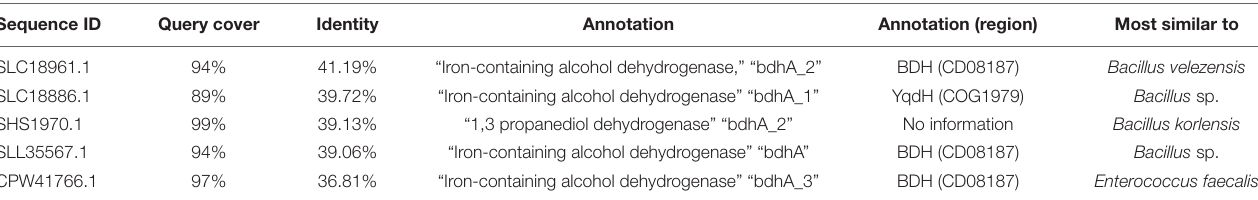
FIGURE 5 | The proposed mechanism for survival of E. coli in glutaraldehyde. (A) % Glutaraldehyde conversion (degradation) by the evolved strains, knockouts, and their respective parental strains. The standard error is shown for duplicates. The p -values are shown above the brackets for each comparison (one-tailed t -test for independent means). (B) Growth of evolved strains, knockouts, and their respective parental strains in 250 µ M of non-toxic 1,5-pentanediol. Such concentration was four to six times higher than the maximum concentration of glutaraldehyde in which evolved strains were able to grow at the otherwise same growth conditions. The standard error is shown for duplicates. (C) Michaelis-Menten kinetics of YqhD at different glutaraldehyde concentrations. K M of YqhD for glutaraldehyde was calculated to be 0.55 ± 0.09 mM (SEM; n = 3 biological replicates). 0.6 mM NADPH and 10 µ g of purified YqhD was used. Inset figure shows purified YqhD on native PAGE. (D) Mechanism of glutaraldehyde tolerance in E. coli MG1655: ALE selected for mutated versions of the transcription factor yqhC, which increased expression of the operon containing yqhD and dkgA . Increased expression of yqhD contributed to the survival of E. coli cells in the presence of glutaraldehyde due to the conversion of such toxic chemical to the innocuous corresponding alcohol, 1,5 pentanediol, by the aldehyde dehydrogenase YqhD. TABLE 3 | Homology results to E. coli ’s YqhD in the Mycobacterium sp. (BLAST-p,